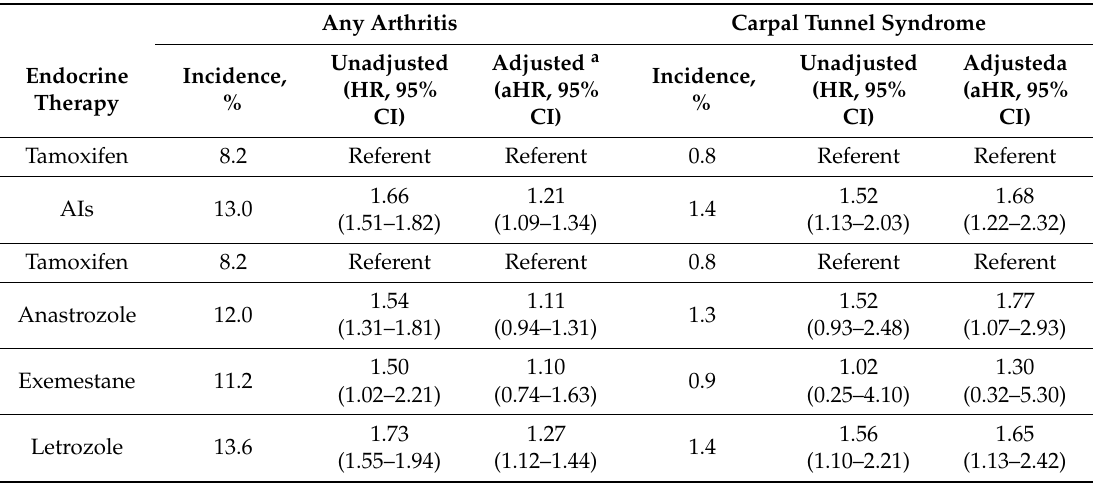
Table 2. Aromatase Inhibitors Use and Risk of Any Arthritis and Carpal Tunnel Syndrome Using Cause-specific Cox